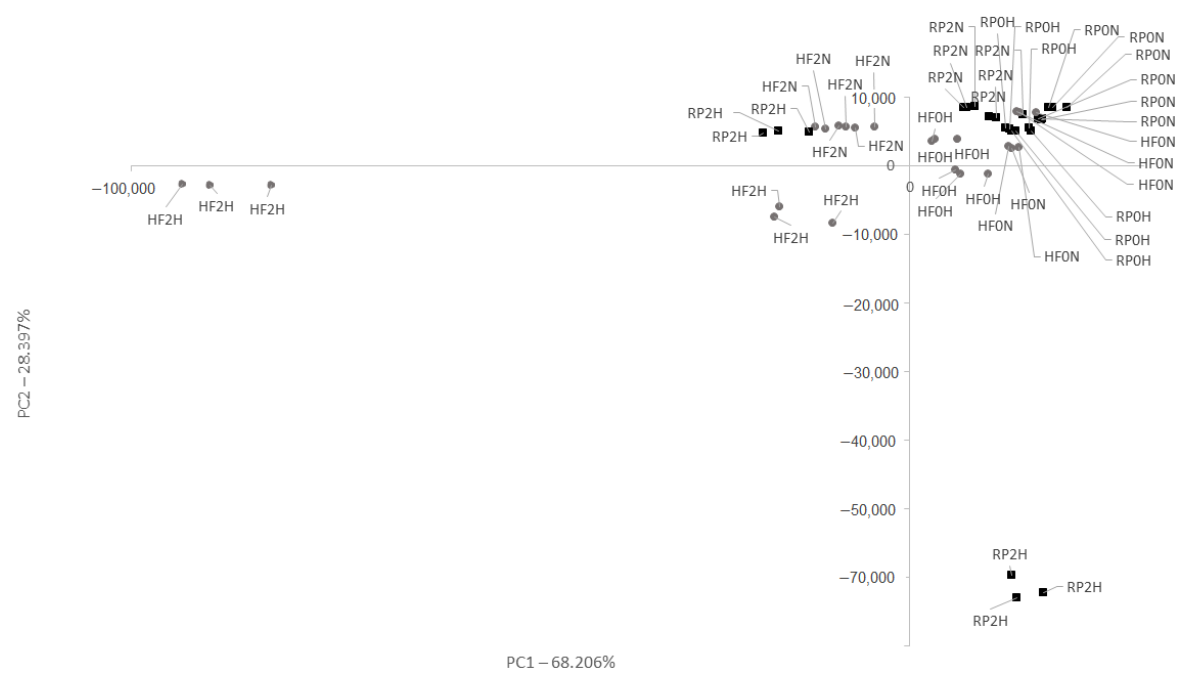
Figure 1. PCA of the cheese aromatic profile. Abbreviations: HF—cheese from Polish Holstein-Friesian breed Black-and-White type milk (gray); RP—cheese from Polish Red breed milk (black); 0—fresh samples; 2—samples stored for 2 weeks at 4 ◦ C; N—cheese with no wild garlic addition; H—cheese with wild garlic.